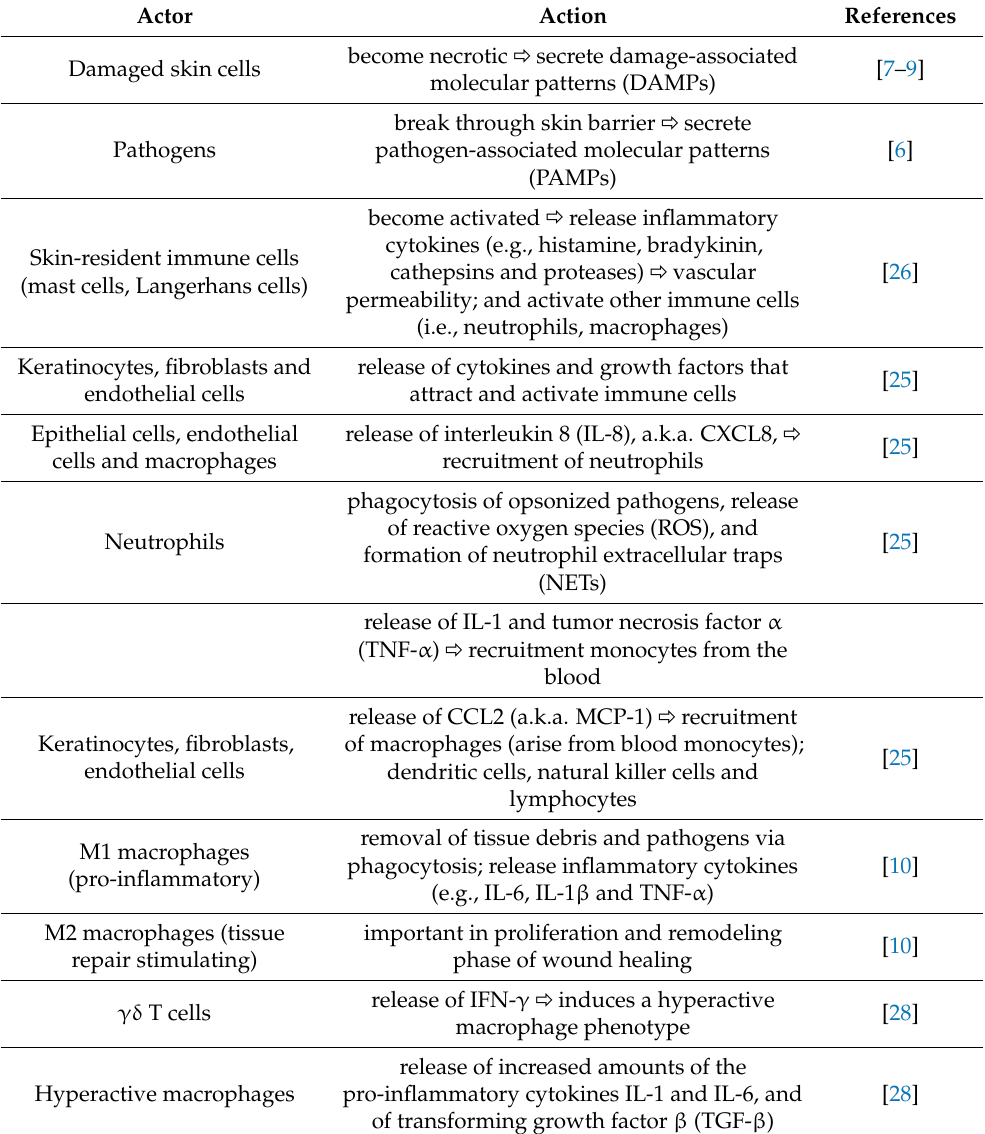
Table 1. An overview of the local events after burn based on the major “actors” and their actions.